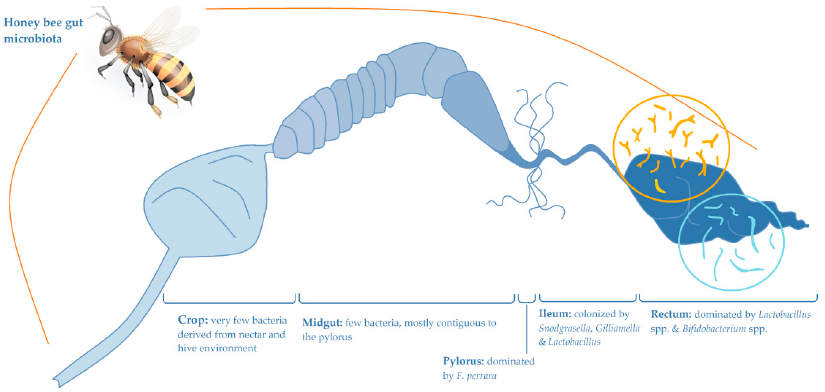
Figure 1. Schematic distributions of honey bee gut microbiota.